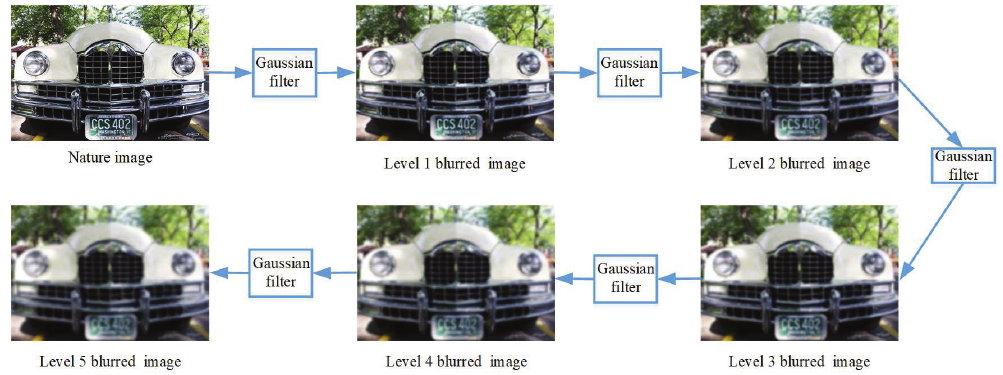
Figure 5. Nature images and filter results of a Gaussian filter with the standard deviation of three and a size of 5 ×